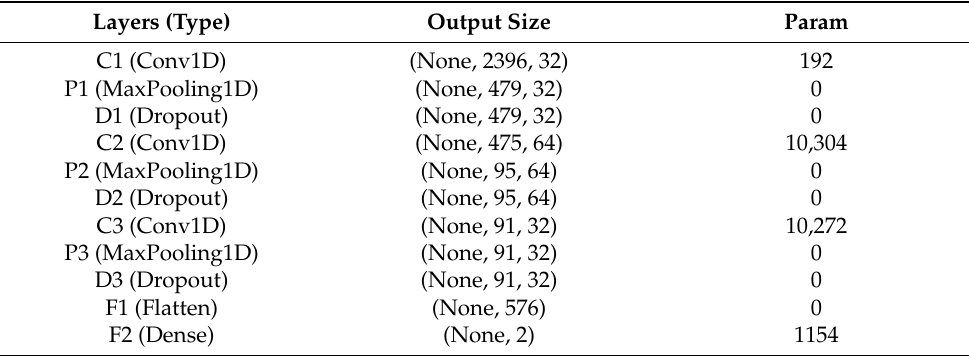
Figure 4. Structural flow chart of the sequence feature regression structure. The network parameters are shown in Table 1. Table 1. Configurations of sequence feature regression structure.